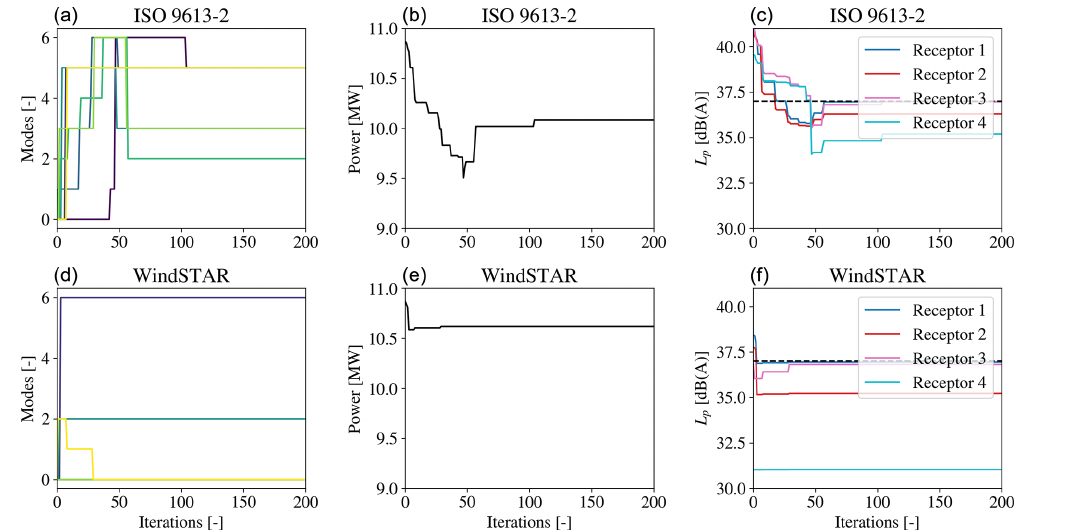
Figure 8. The operational mode, m i , for each wind turbine (a, d) ; the overall power, P , of the row of seven SWT-2.3-93 wind turbines (b, e) ; and the integrated sound pressure level, L p ,j , at each receptor (c, f) during the optimization at θ = 0 ◦ and U hub = 9 . 3ms − 1 . The noise constraint is set to L p , lim ,j = 37dB(A) and represented by the dashed line in the right figure.